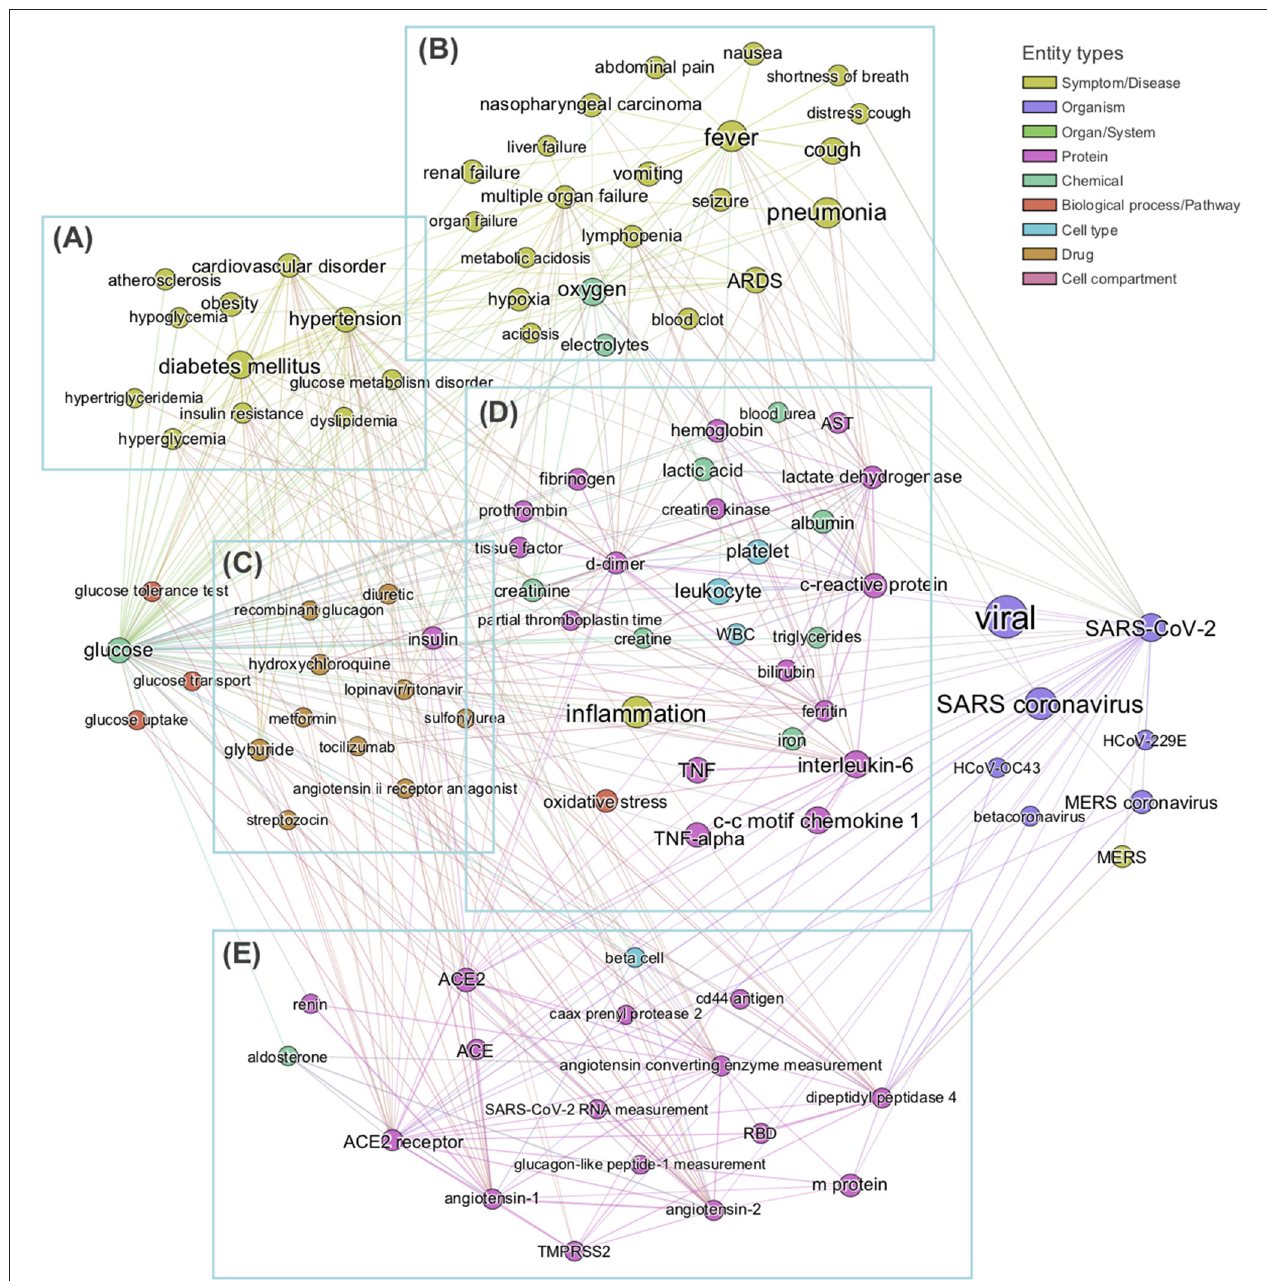
FIGURE 3 | Subgraph obtained by aggregating the 20 Best Mutual Information Pathways from “glucose” to “SARS-CoV-2.” The subgraph was constructed with the entities encountered during the mutual information guided shortest path search (see section Methods) from “glucose” to “SARS-COV-2” Node sizes are proportional to the weighted degree of nodes and node colors represent different entity types. Analysis of entities detected allows us to identify five groups of entities, each related to a specific field in coronavirus infection: (A) comorbidities in high-risk group, (B) SARS-related symptoms and complications, (C) SARS-related drugs, (D) SARS biomarkers and inflammation, (E) coronavirus receptors and RAAS system. No entities from c ell compartment or organ/system entity types were detected in this analysis.